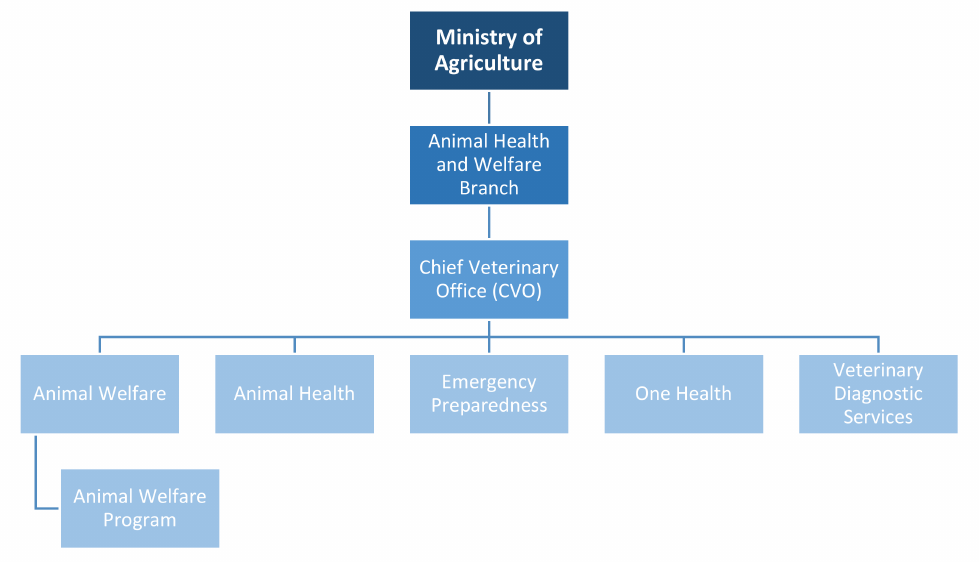
Figure 3. Ministry Structure and